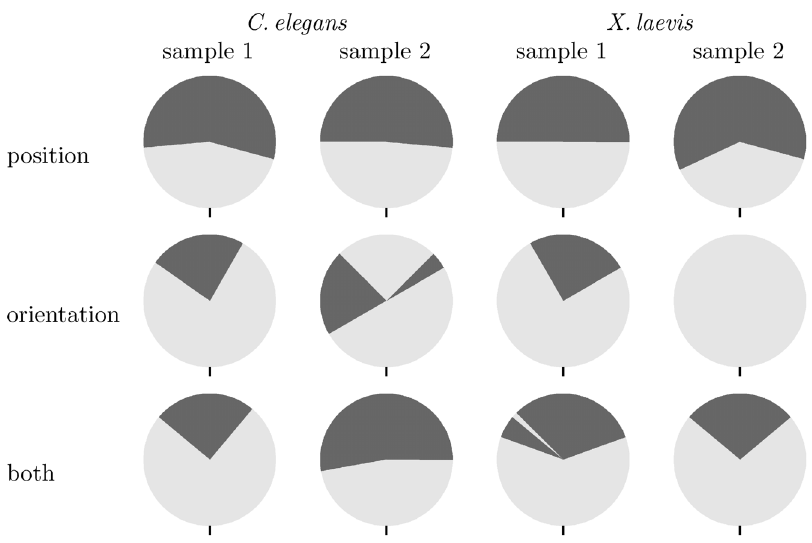
Figure 11. Stability of alignment. We rotated one section of a pair of correctly aligned sections for several samples over a range of 360 ˚ at 5 ˚ steps, as depicted by the circles, and tested whether the algorithms recovered the originally correct orientation, which is indicated by a vertical bar at the bottom of each circle. Dark gray indicates failure of the algorithm to recover the original rotation angle. Light gray indicates that the algorithm discovered the correct rotation. All algorithms found correct alignments for small rotations (light gray area in bottom half of each circle). The algorithm for linear alignment from orientation was most successful (largest light gray areas in middle row). Top: Rigid point set registration algorithm by Myronenko and Song (Figure 2 in [28]). Middle: Algorithm for linear alignment from orientation (Figure S1). Bottom: Algorithm for linear alignment from position and orientation (Figure